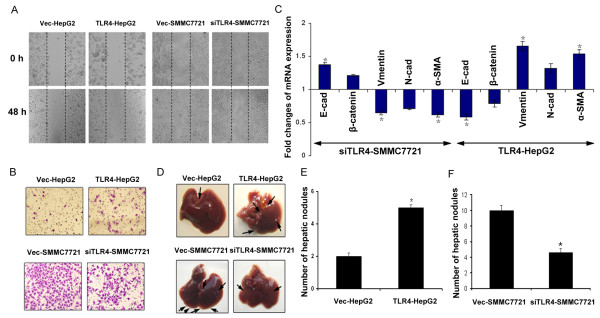
Alteration of TLR4 influences LPS-induced metastasis and EMT of HCC cells. (A) and (B) HepG2 cells were transduced with adeno-associated virus to express TLR4 and SMMC-7721 cells were transduced with siRNA to knocked down TLR4, and then the cells were treated with LPS. The migration of pretreated HCC cells was determined by the wound healing assay (A, × 200) and the invasiveness of pretreated HCC cells was determined by the Transwell assay (B, × 200). (C) Expression of EMT genes in pretreated HCC cells was detected by qPCR (normalized to β-actin) Results presented represent the mean of triplicate experiments ± SEM (*P < 0.05, **P < 0.01). (D) Pictures of metastatic liver nodules in nude mice by splenic-vein injection of pretreated HCC cells (× 200). The arrows indicate the metastatic tumor on the surface of the liver (n = 10 per group). (E) and (F) The number of nodules was quantified on nude mice livers by splenic-vein injection of pretreated HCC cells. Values for individual mice are shown above the bars (*P < 0.05). EMT, epithelial-mesenchymal transition; HCC, hepatocellular carcinoma; LPS, lipopolysaccharide; SEM, standard error of the mean; TLR4, toll-like receptor 4.